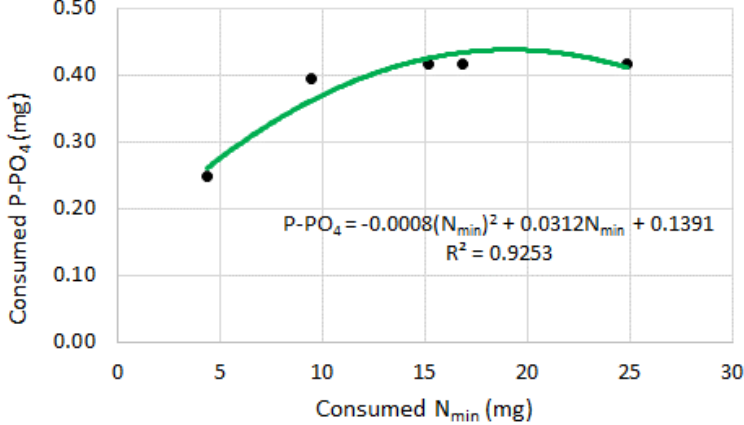
Figure 5. Changes in consumed P-PO 43 − in relation to changes in consumed N min during the cultivation of Monoraphidium sp. in AWW ( R 2 = 0.9653 at p < 0.05).